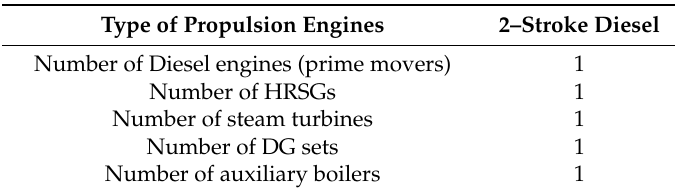
Table 26. Optimal synthesis of the